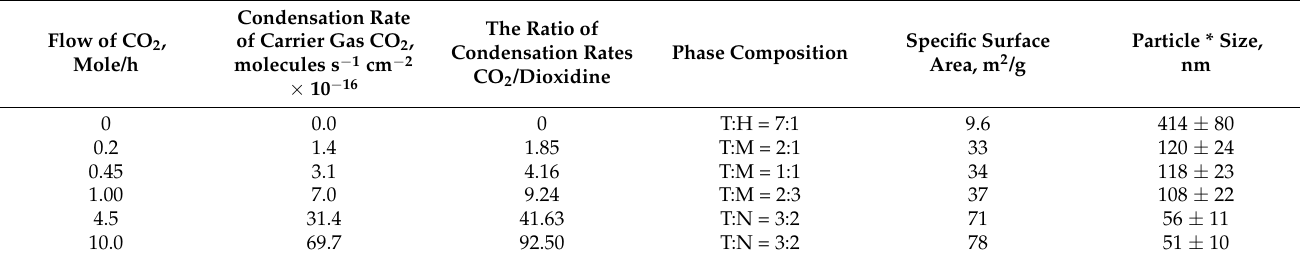
* Measured by chromatographic determination of the specific surface area of the samples using low temperature adsorption of inert gas argon, followed by its desorption during thermos-programmed heating (see Section